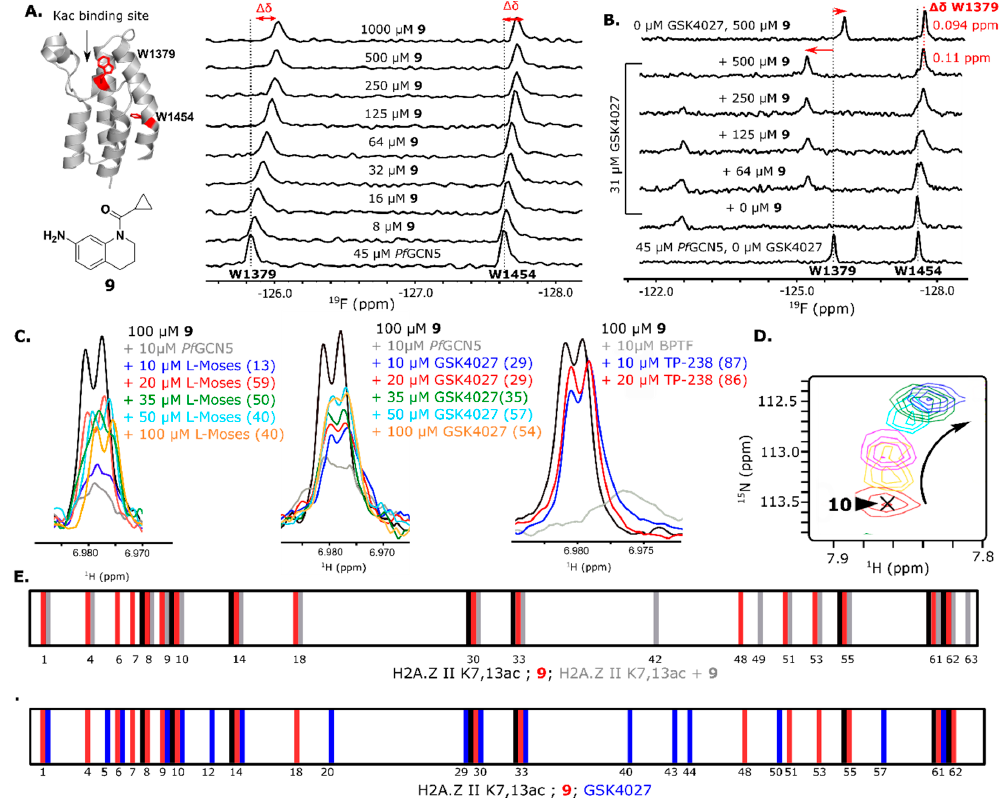
Figure 2. ( A ) Fragment 9 and Pf GCN5 (PDB 4QNS) with the W locations highlighted. PrOF NMR titration of 9 with Pf GCN5. ( B ) PrOF NMR titration of 9 with GSK4027 present at a saturating concentration. ( C) Competition 1 H CPMG NMR. The percent recovery for the addition of each competitor is shown in parentheses. ( D ) 1 H- 15 N HSQC NMR non-linear movement of resonance 10 when titrated with 9 . The arrow indicates the direction of movement with increasing concentrations of 9 (0 µM = red, 16 µM = yellow, 32 µM = pink, 64 µM = teal, 125 µM = green, and 250 µM = blue). ( E ) Strip plots of Pf GCN5 1 H- 15 N HSQC NMR resonances with Δδ > x ̄ + 0.60 *s at the highest concentration tested (black = H2A.Z II K7,13ac, red = 9 , blue = GSK4027, and gray = 9 + H2A.Z II K7,13ac).